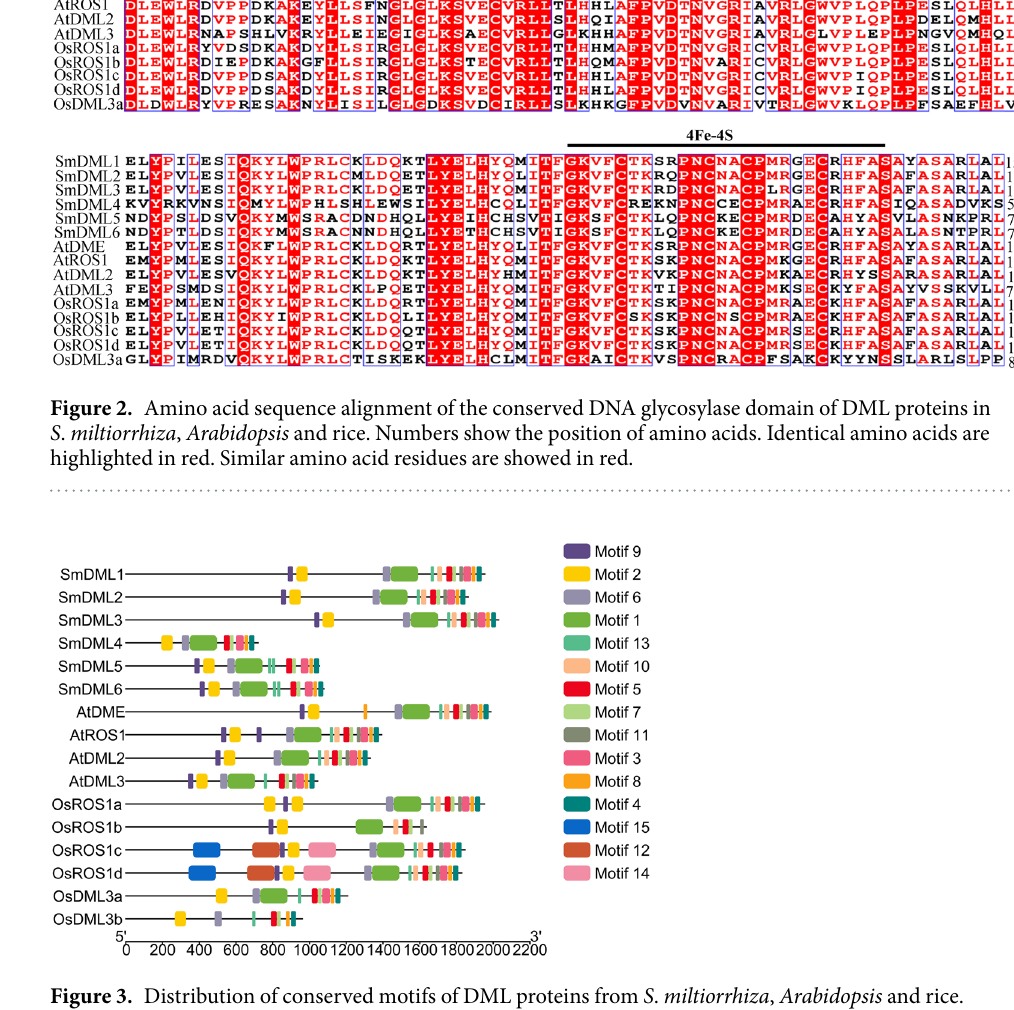
Figure 3. Distribution of conserved motifs of DML proteins from S . miltiorrhiza , Arabidopsis and